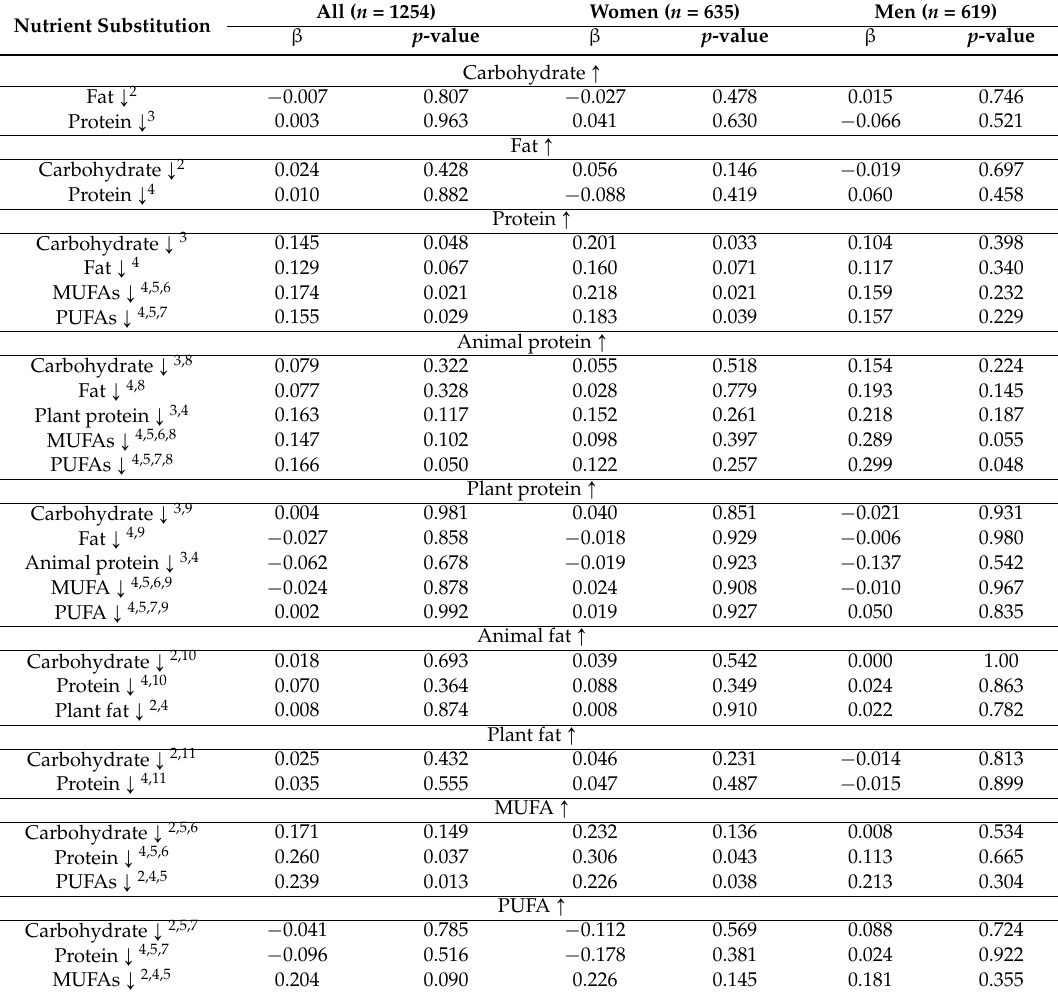
Table 3. Adjusted 3-year visceral adiposity index (VAI) change for the iso-energetic increase ( Ò ) of 5% of energy from one macronutrient at the expense of another ( Ó ) 1